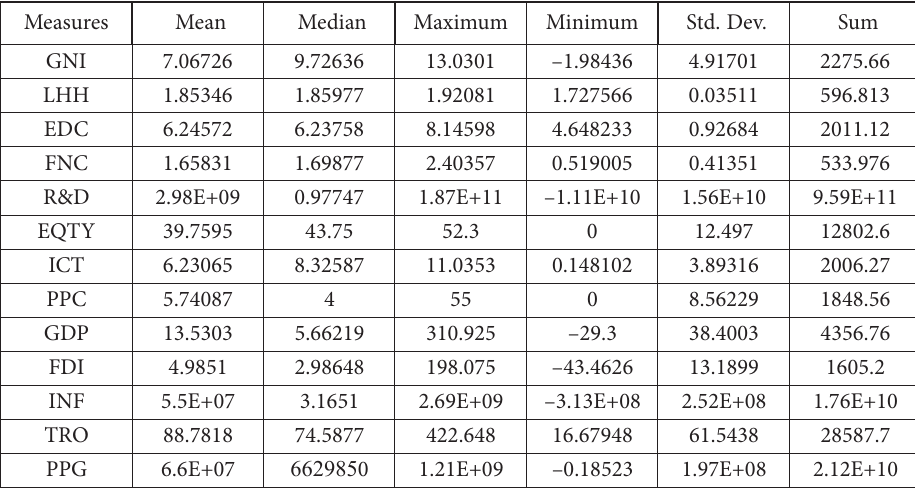
Table 2. Descriptive Statistics of the Selected Variables (source: author’s computation using E-views 9.0 (IHS Global Inc.,